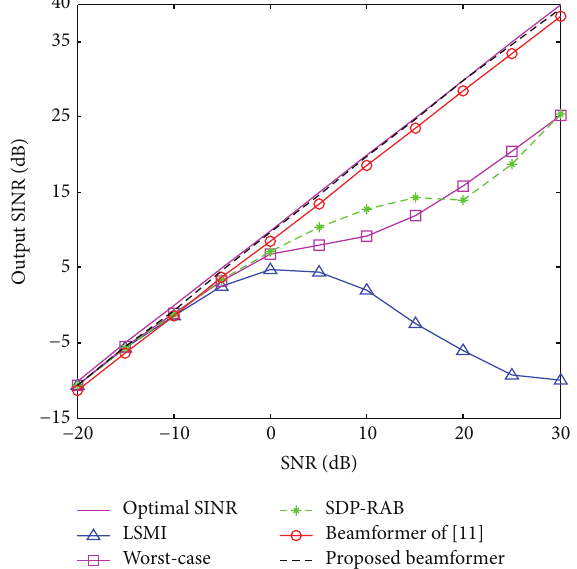
Figure 4: Output SINR versus the number of snapshots in the case of look direction mismatch.